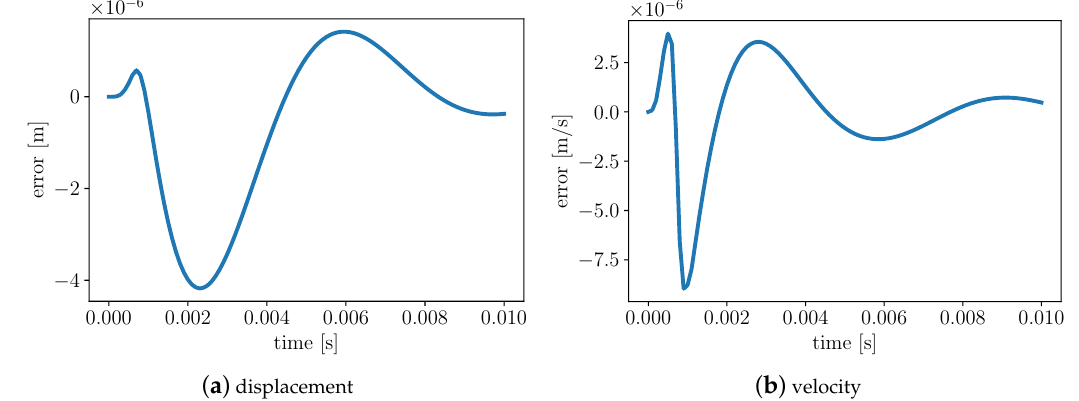
Figure 12. The error between prediction of the 2nd and 3rd PC order for the displacement and velocity at the mid-span. The error measure is defined as error p‚q “ p‚q 3 rd ´ p‚q 2 nd